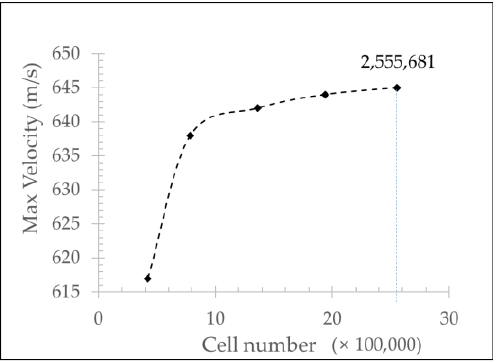
Figure 6. Grid dependency of the maximum velocity of the flow.